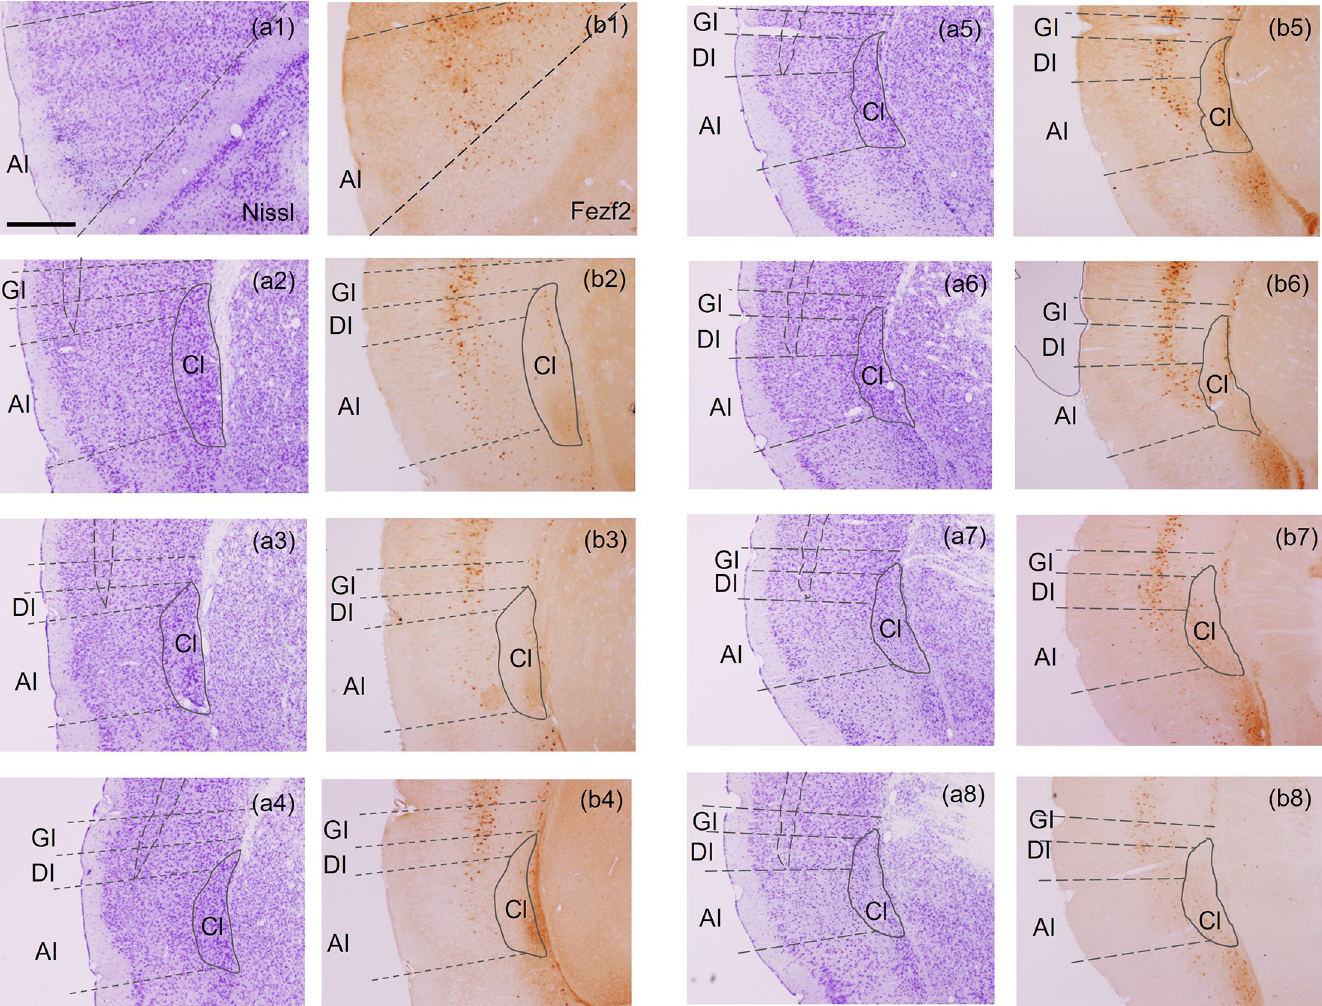
Fig 1. Fezf2 was expressed in layer V/VI neurons of the mouse insular cortex. Sections were numbered in rostral-caudal order. (a1)–(a8); Nissl staining. (b1)–(b8); adjacent tissue sections of (a1)–(a8). Fezf2 was expressed widely in rostral-caudal axis in layers V/VI. Fezf2 was visualized by immunohistochemistry against RFP in Tg (Fezf2-tdTomato) mice. Dotted lines indicate the borders of GI, DI and AI. Scale bar: 200 μ m.